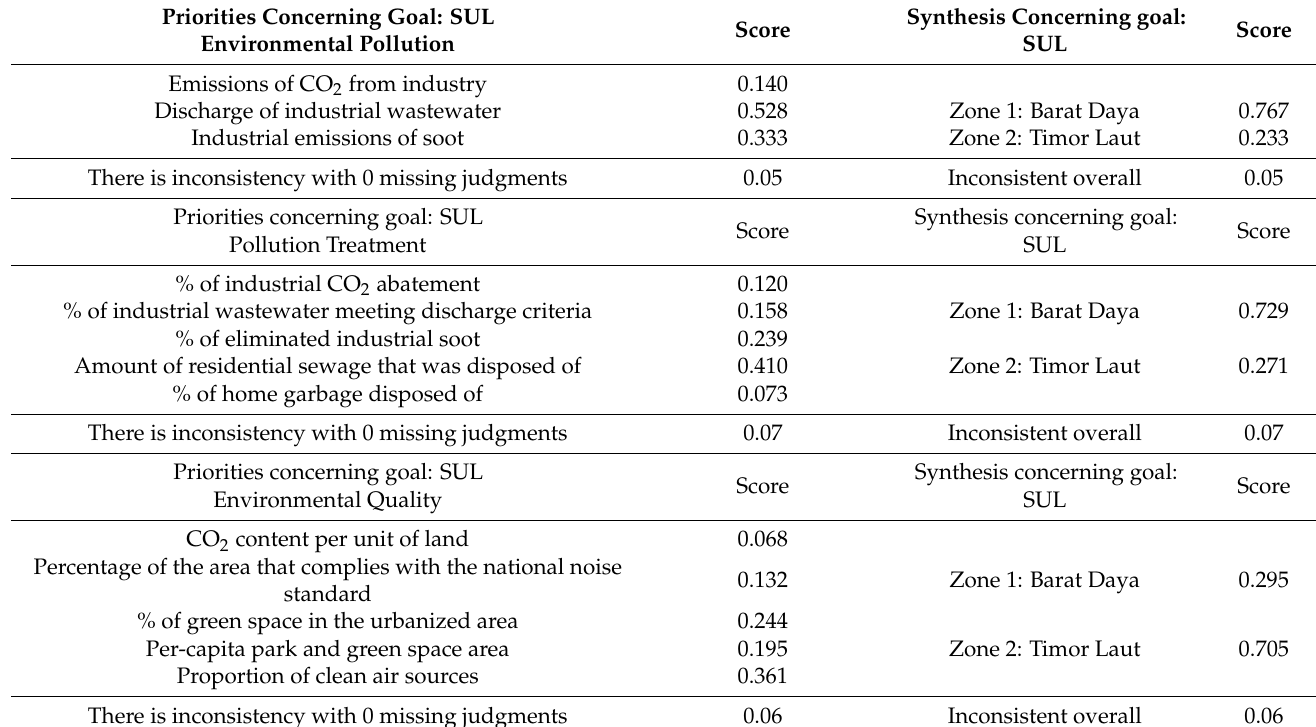
Table 8. Final weights for environmental criteria, sub-criteria, and alternatives to the urban